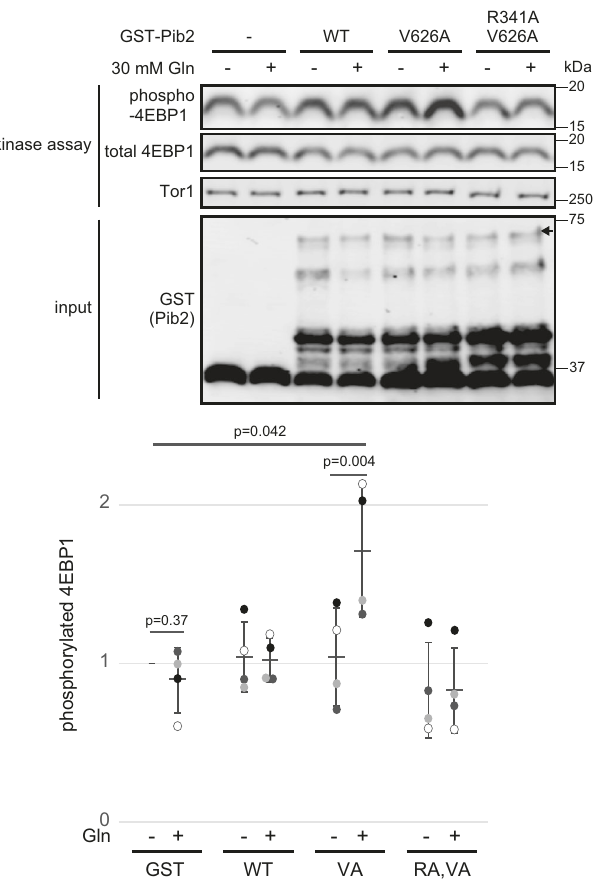
Fig. 4 Pib2 directly activates TORC1 in vitro in response to glutamine. In vitro kinase assays were performed using TORC1 puri fi ed from Kog1-Tap expressing cells and bacterially-expressed GST-Pib2(304-635) with or without 30mM L-glutamine. Dot plots represent the ratio of phosphorylated/total 4EBP1 normalized to sample with GST but without glutamine. Error bars represent the standard deviation ( n = 4 independent experiments), and signi fi cance was determined by a two-tailed Student ’ s t